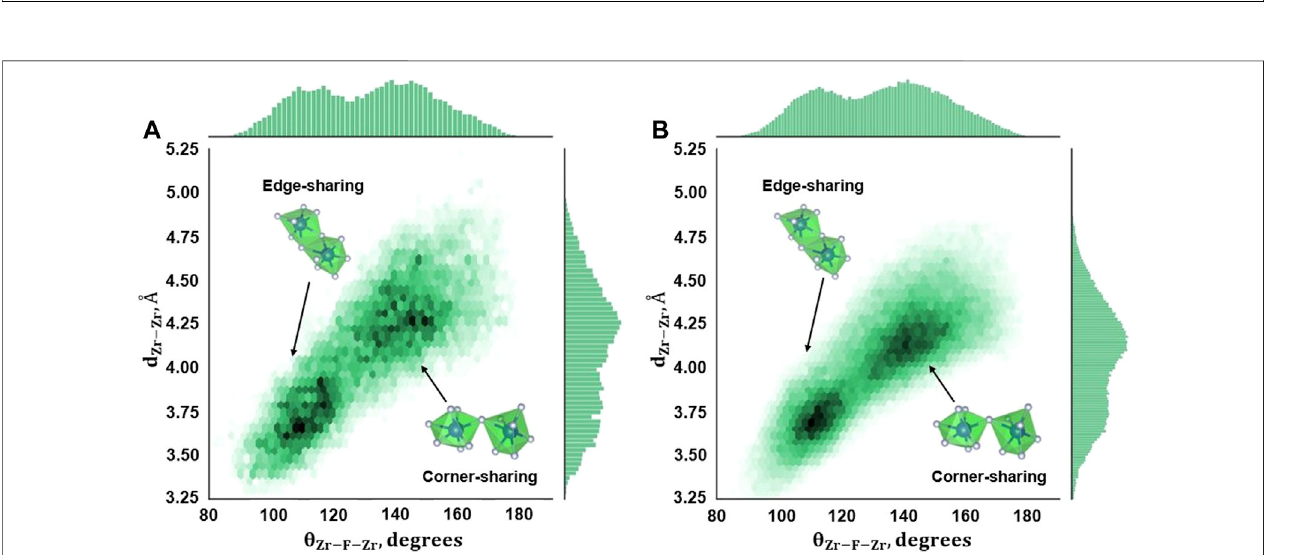
Frontiers in Physics |